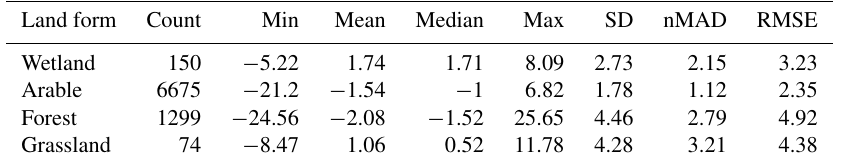
Table 4. Statistical description of SOC prediction error per land form.